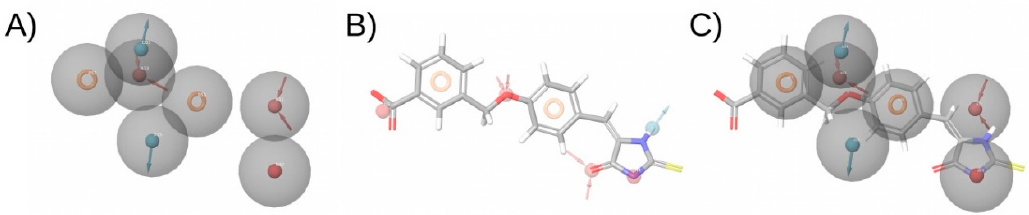
Figure 5. Pharmacophore model and fitting compound. ( A ) shows the pharmacophore model. ( B ) Shows the compound and its pharmacophoric features. ( C ) Shows a superposition of the compound and the pharmacophore, showing that the compound matches four sites in the pharmacophore. The hydrogen bond acceptor, hydrogen bond donor, and aromatic and negative ionizable features are shown in red, blue, and orange and red, respectively. The arrows in the hydrogen bond acceptor and hydrogen bond donor features indicate the direction of the hydrogen bond. This figure was obtained with Maestro [33].